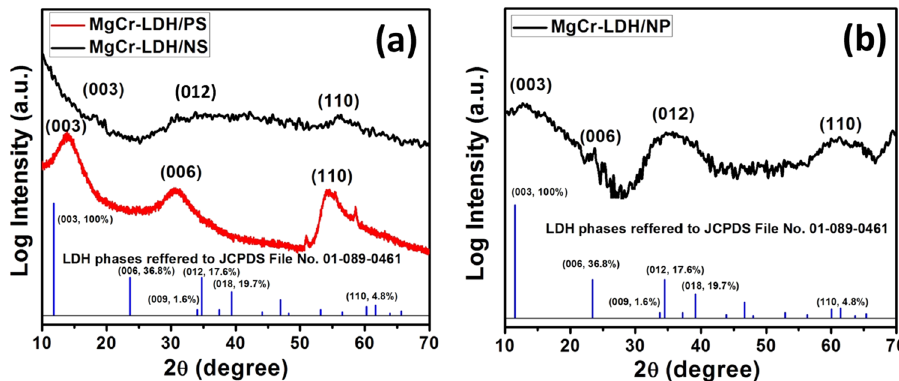
Figure 3. ( a ) PXRD spectra of MgCr-LDH/PS and exfoliated MgCr-LDH/NS; ( b ) PXRD spectra of MgCr- LDH/NP under the influence of hydrothermal treatment of 80 °C and visible light exposures of 30